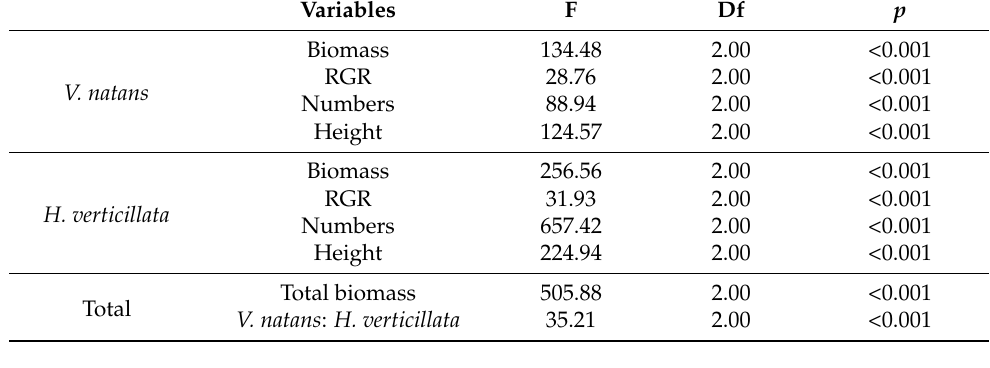
Light (target depth: surface)